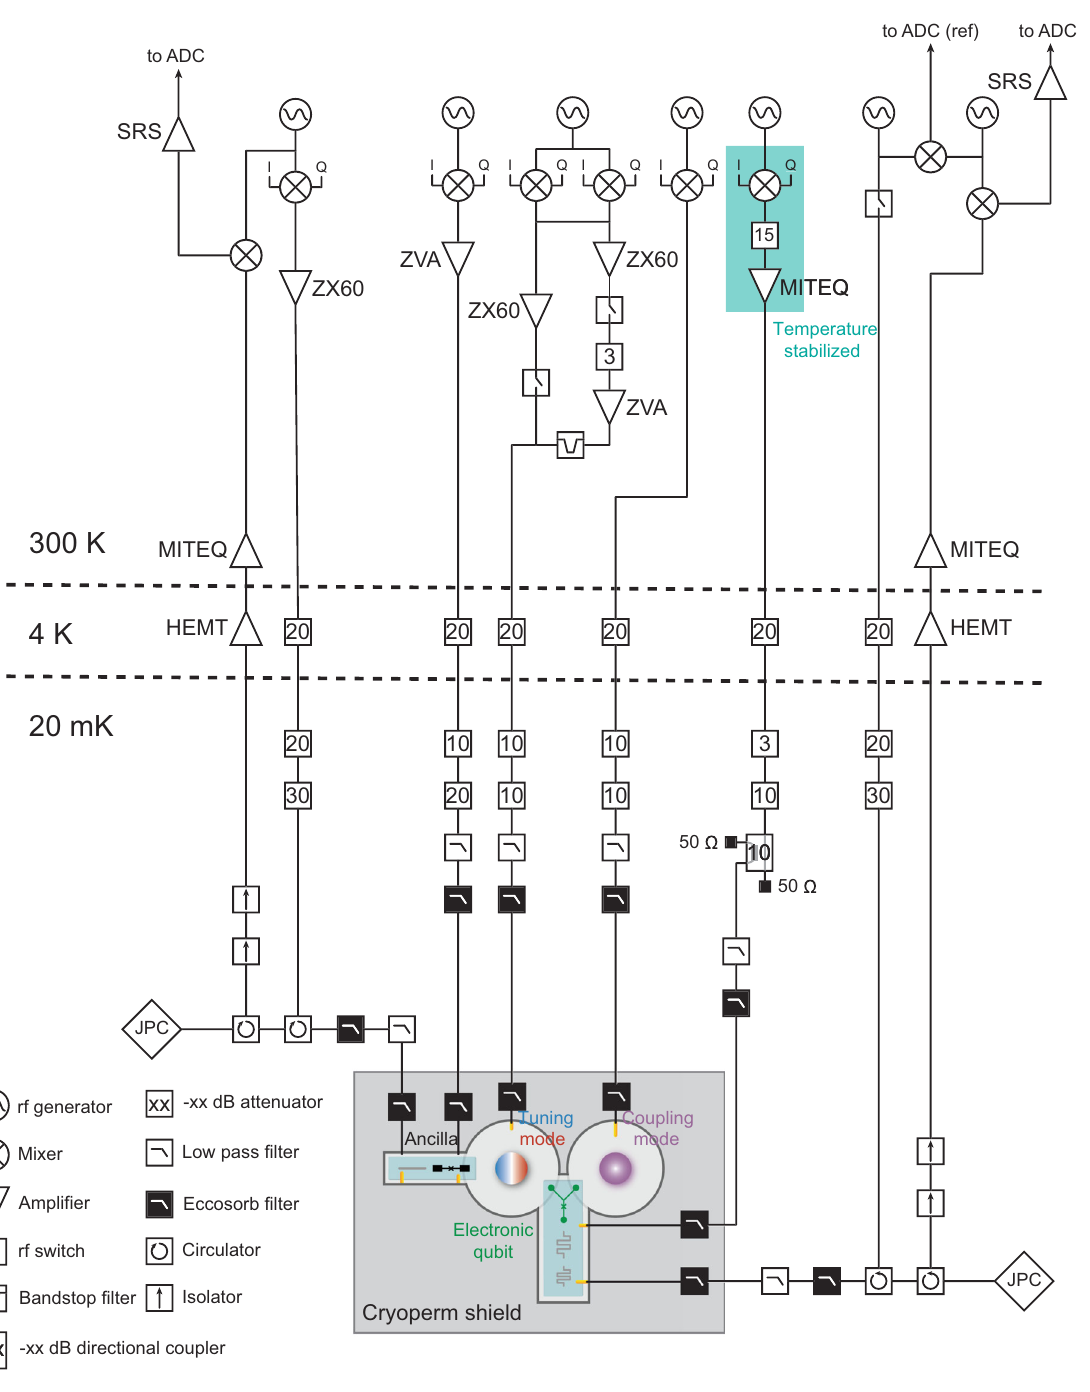
FIG. 6. Experimental wiring